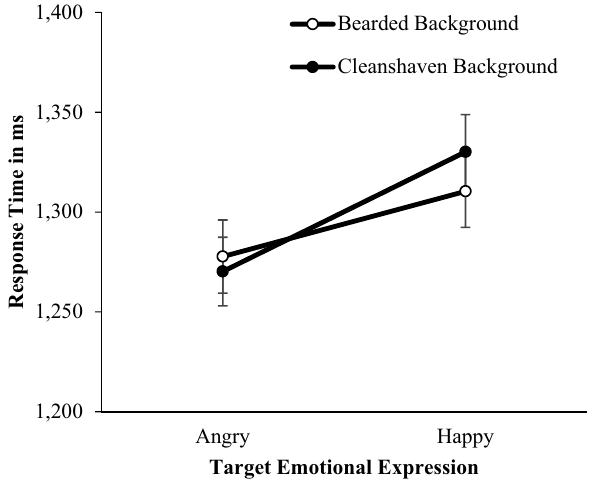
Figure 9. Mean response times in milliseconds (± 1 SEM) for Study 3 identifying target angry or happy expressions which vary in beardedness, in bearded or clean-shaven